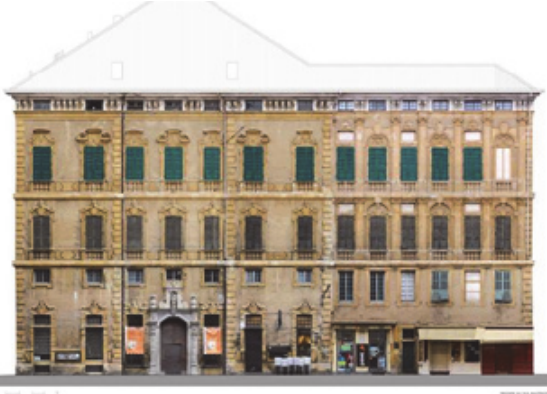
Figure 6: Palazzo Borea D’Olmo (Im) 2014.